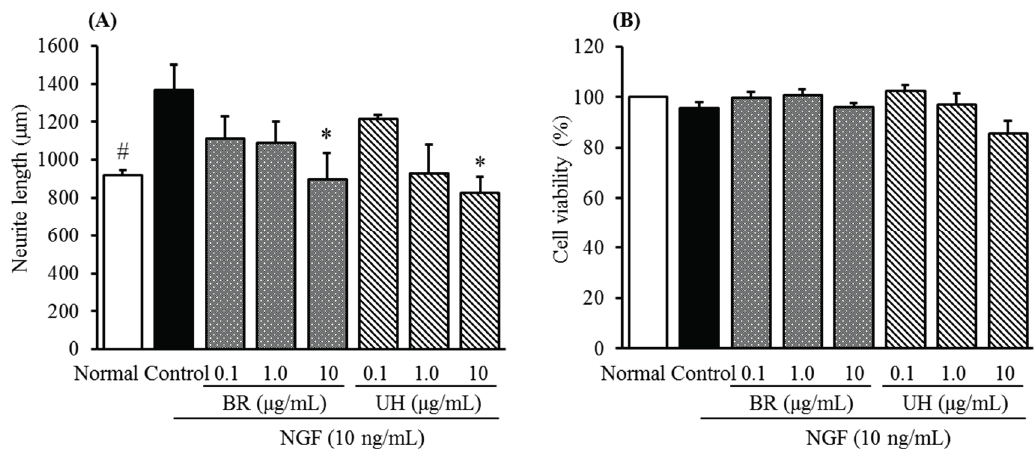
Figure 3. Inhibitory activities of Bupleurum Root (BR) and Uncaria Hook (UH) against NGF-induced neurite growth ( A ) and cell cytotoxicity in cultured DRG neurons ( B ). Values are the means ± S.E.M. of triplicate experiments. # p < 0.05 vs . Control (Student’s t- test); * p < 0.05 vs. Control (Dunnett’s test).